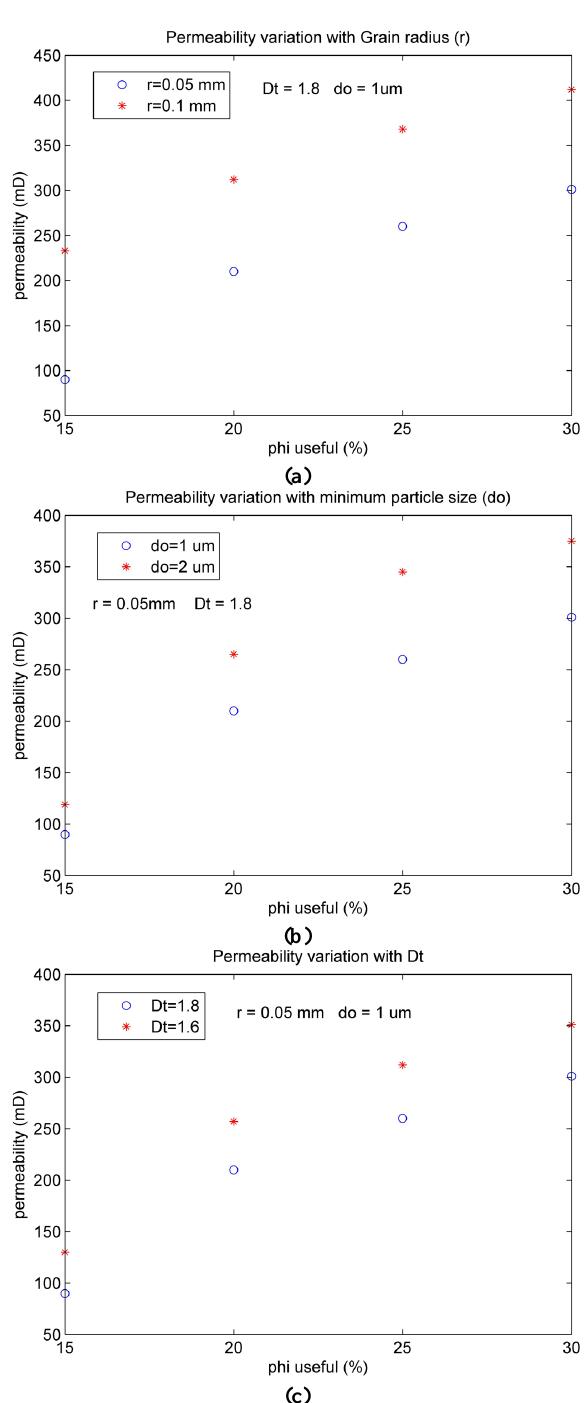
Fig. 3. (a) , (b) and (c) , respectively shows permeability variations with grain radius ( r ), minimum particle size ( d 0 ) and tortuosity frac- tal dimension ( D t ) . Permeability decreases with an increase in D t and increases with an increase in r and d 0 . The variation in perme- ability is more sensitive to changes in grain